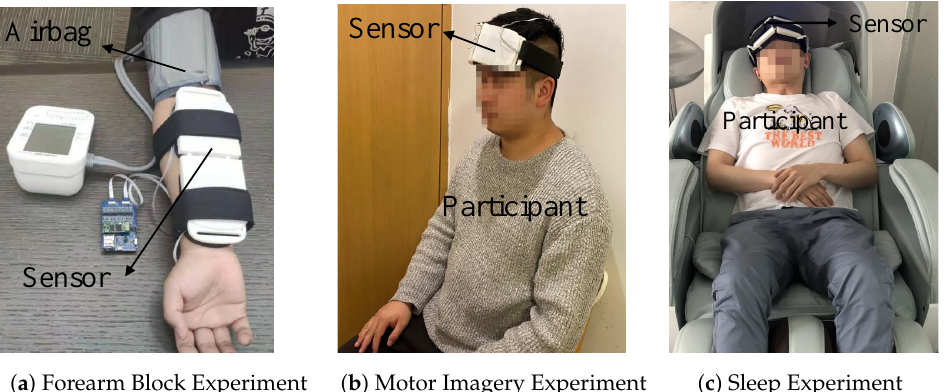
Figure 5. ( a ) Each participant wore the measurement system and an inflatable airbag on their arm in the forearm arterial occlusion experiment. ( b ) Each participant wore the measurement system on their forehead in the motor imagery experiment. ( c ) Each participant lay in a pod and wore the measurement system on their forehead in the sleep